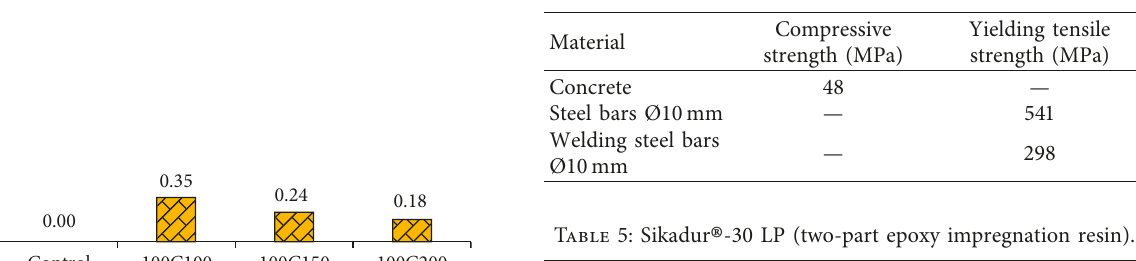
Table 4: Mechanical properties of the concrete and NSM steel bars.